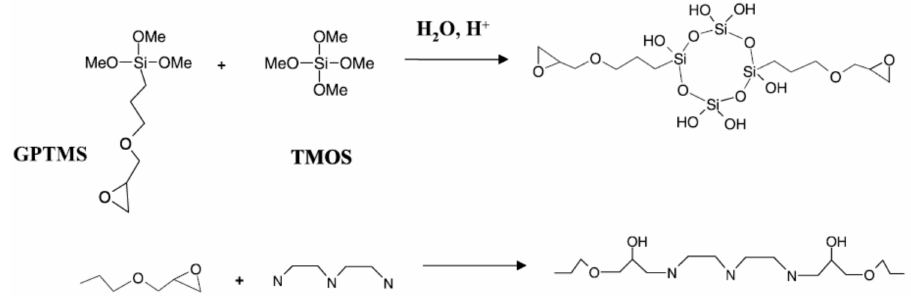
Figure 7. Schematic diagram of the SNAP coating process. Reprinted with permission from Ref. [24]. Copyright 2003, Elsevier.